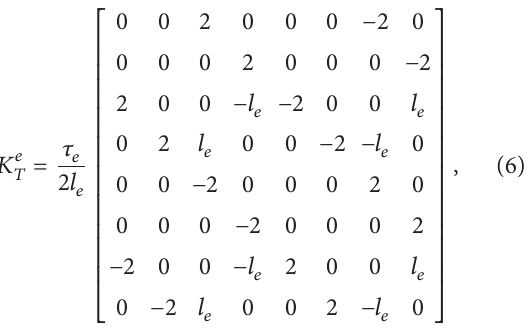
Figure 1: The local coordinates in the bending planes.